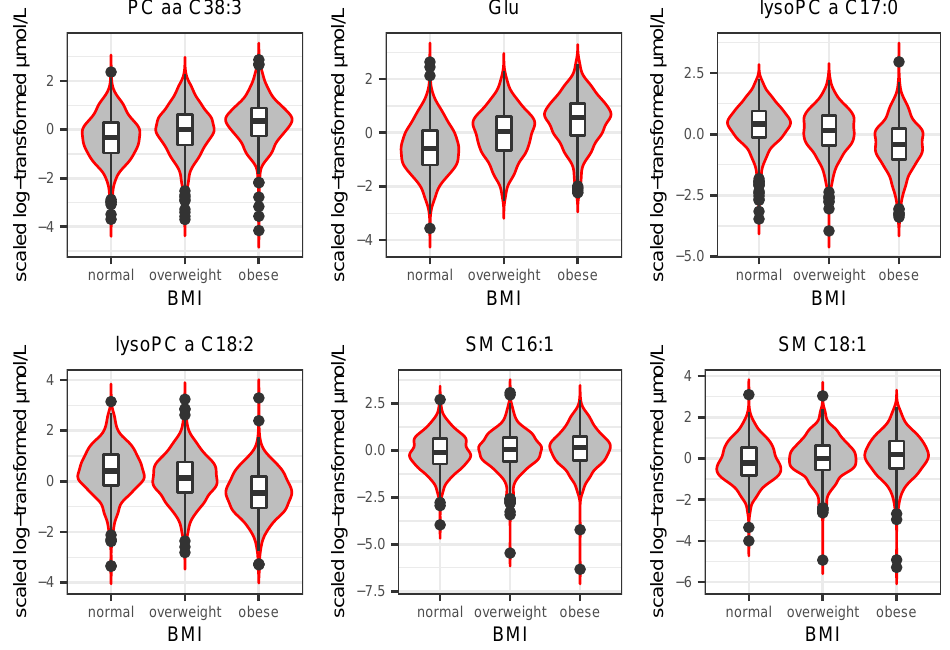
Figure 3. Violin-boxplots show the top six significant metabolite distributions of study subjects divided in three different classes of BMI, normal (18.5 ≤ BMI < 25), overweight (25 ≤ BMI < 30), and obese (BMI ≥ 30). The box contains 50% of the participants. The middle line stands for median dividing the box into two areas. The 25th and 75th percentile of the distribution are represented by upper and lower